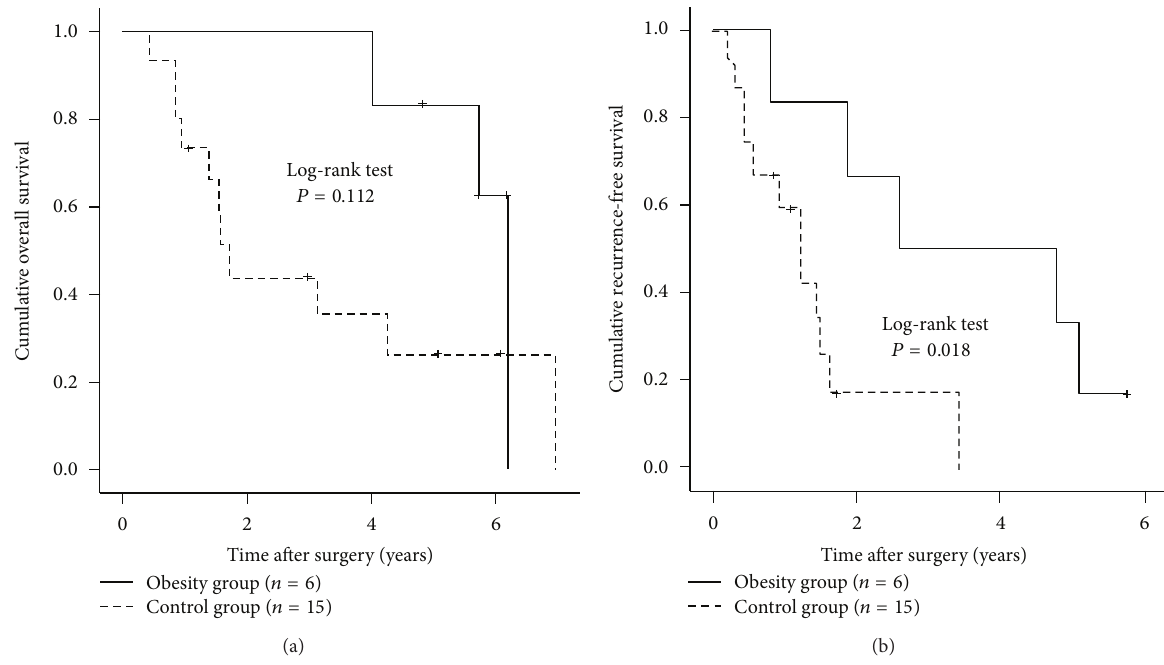
Figure 7: Subgroup analyses in patients with the Child-Pugh grade B ( 𝑛 = 21 ). There were six patients with the Child-Pugh grade B in the obesity group and 15 in the control group. In terms of OS (a), there was no significant difference between the two groups ( 𝑃 = 0.112 ). However, RFS rates in the obesity group were significantly higher than those in the control group (b) ( 𝑃 = 0.018